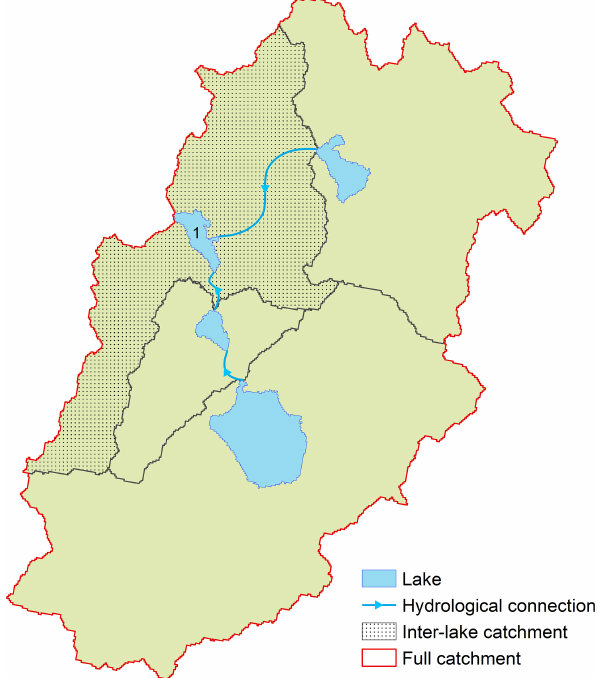
Figure 3. Illustration of the inter-lake catchment (stippled black area) and full catchment (green area).